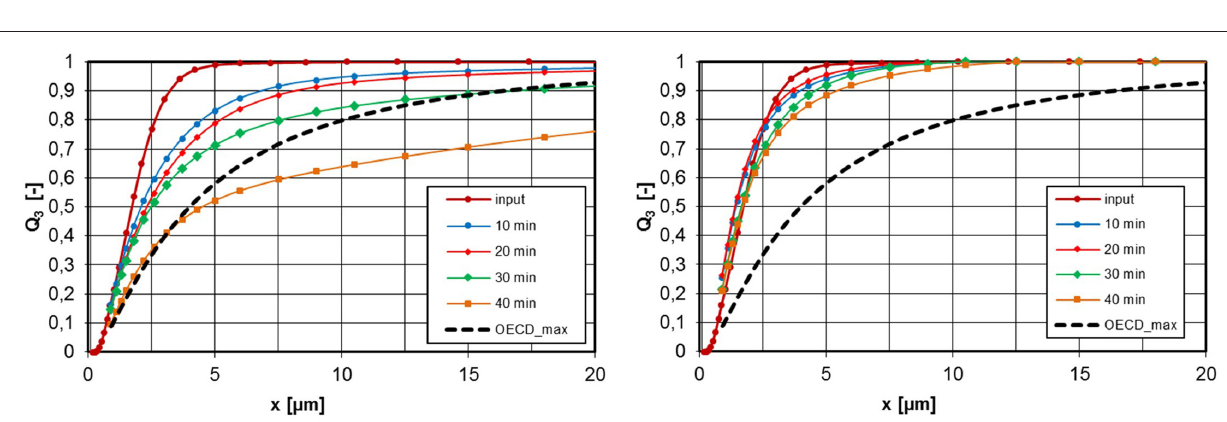
conditions of the system, the concentration and the total test duration must all be considered. For the powder systems